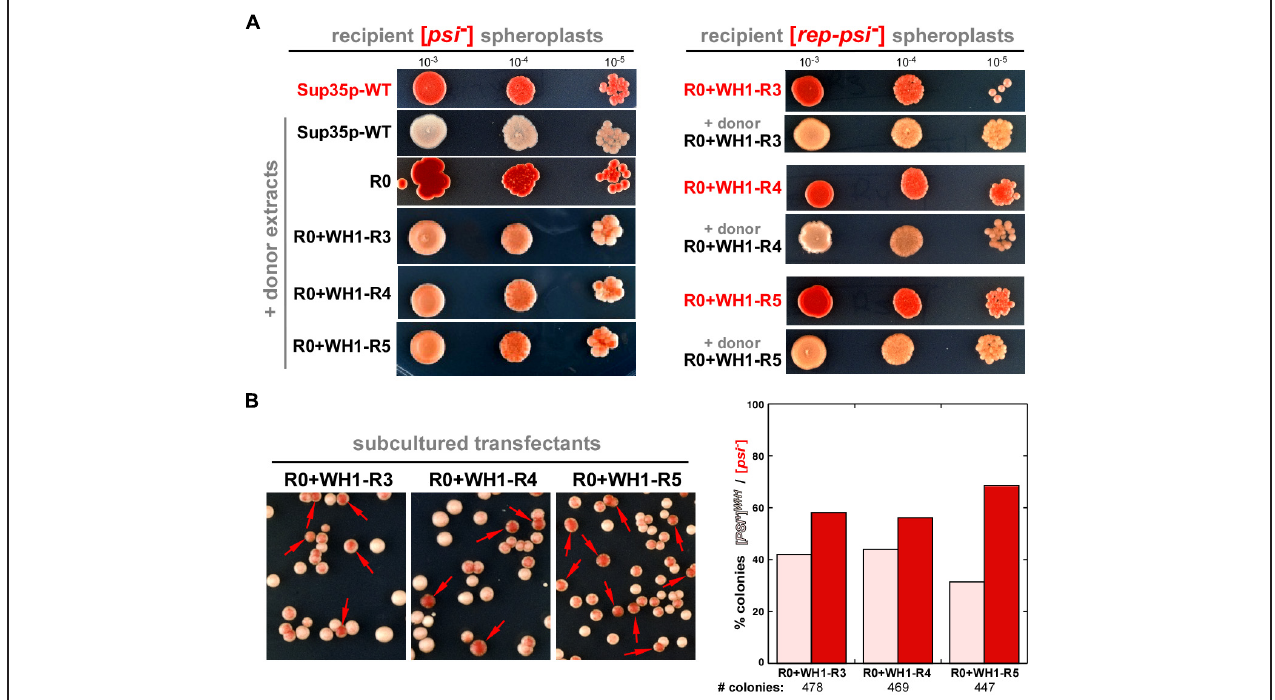
FIGURE 3 | [ REP-PSI + ] aggregates template a prion phenotype on recipient [ psi − ] and [ rep-psi − ] cells. (A) Yeast spheroplasts prepared from red [ psi − ] (left) or [ rep-psi − ] (right) colonies that had spontaneously lost the prion phenotype (red labels) were transformed with extracts from either [ PSI + ] or [ REP-PSI + ] cells (black labels). Ten-fold serial dilutions of cultures from the transformed colonies, starting with OD 600 = 0.001, were plated on 1 / 4 YPD agar. [ REP-PSI + ] extracts were able to confer a light pink, weak [ PSI + ]-like phenotype to the recipient cells expressing Sup35p-WT (left), or a [ REP-PSI + ] phenotype to those expressing the indicated R0 + WH1-R3-5 chimeras (right). (B) Cells